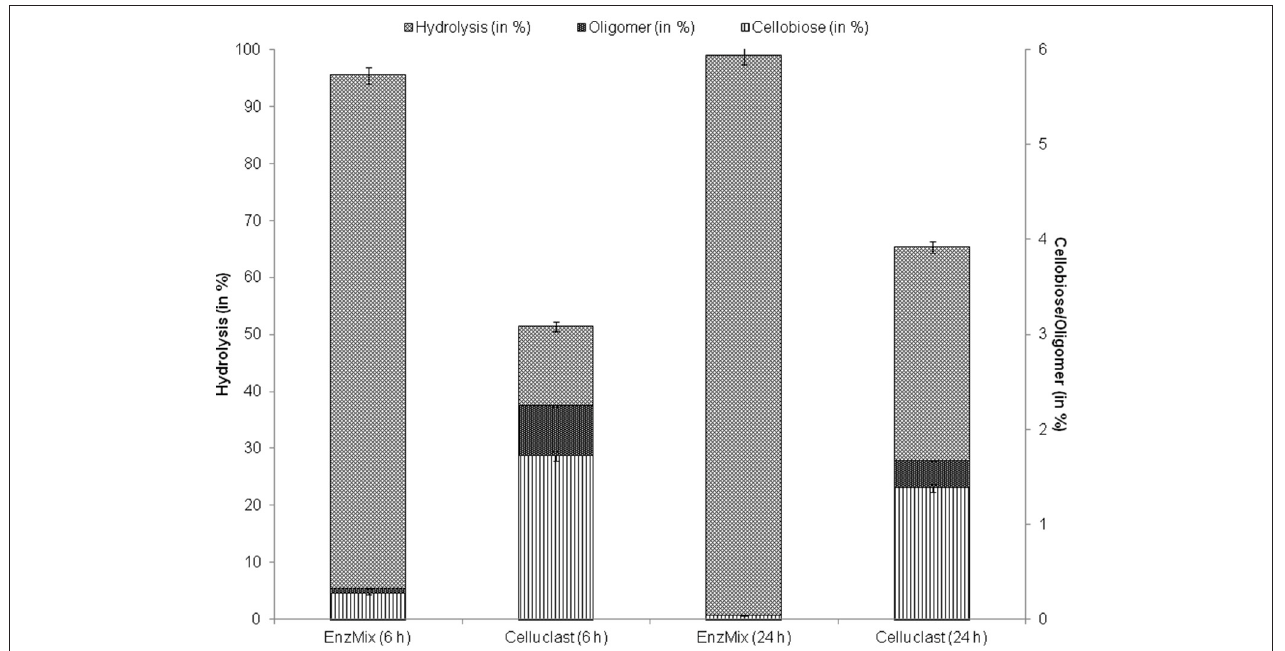
FIGURE 4 | Comparison of steam pretreated wheat straw hydrolysis with EnzMix and Celluclast.